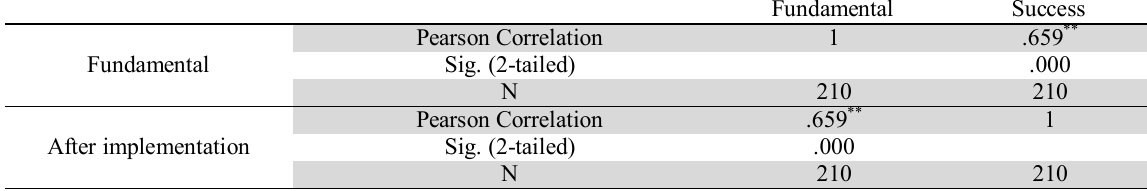
Fundamental Success